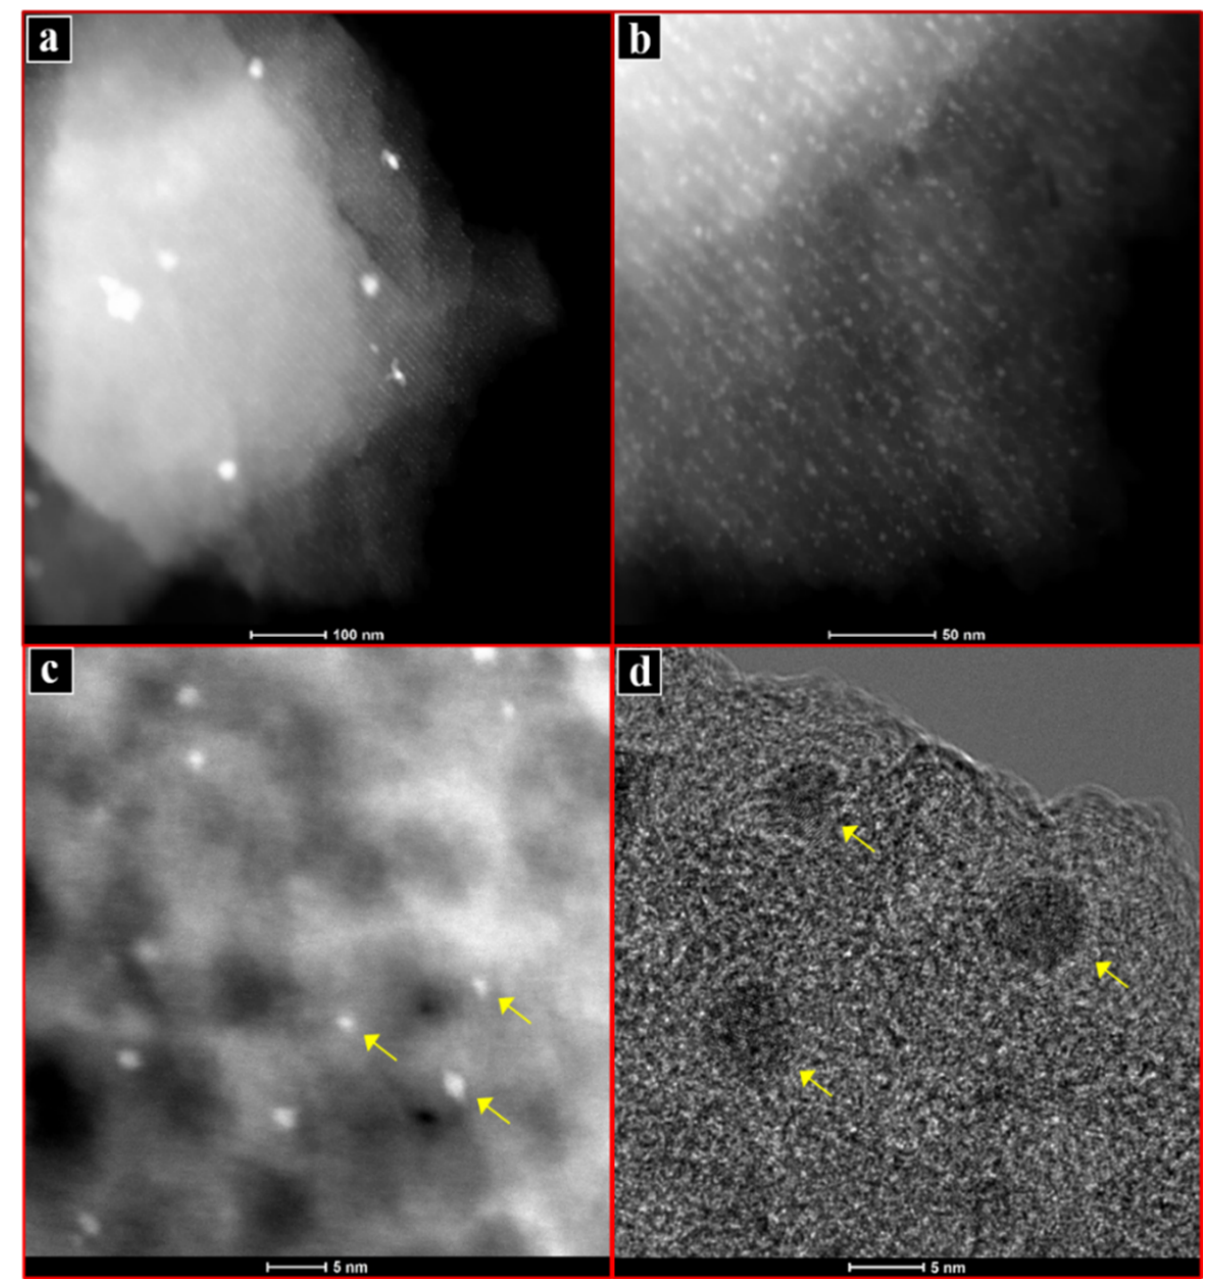
Figure 5. HAADF images of the catalyst DS-Pd after HDC testing in which Pd has bright contrast: ( a ) at low magnification showing a few large Pd particles outside the mesopore structure; ( b ) at intermediate magnification showing the alignment of the Pd particles within the cylindrical pores; and ( c ) ~1 nm Pd particles located on the mesopore edges (examples arrowed). ( d ) TEM image showing the lattice planes of 3–5 nm Pd particles (arrowed).